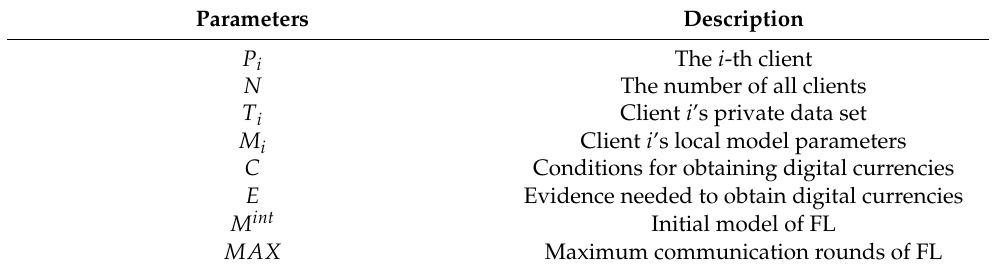
Table 1. Summary of main